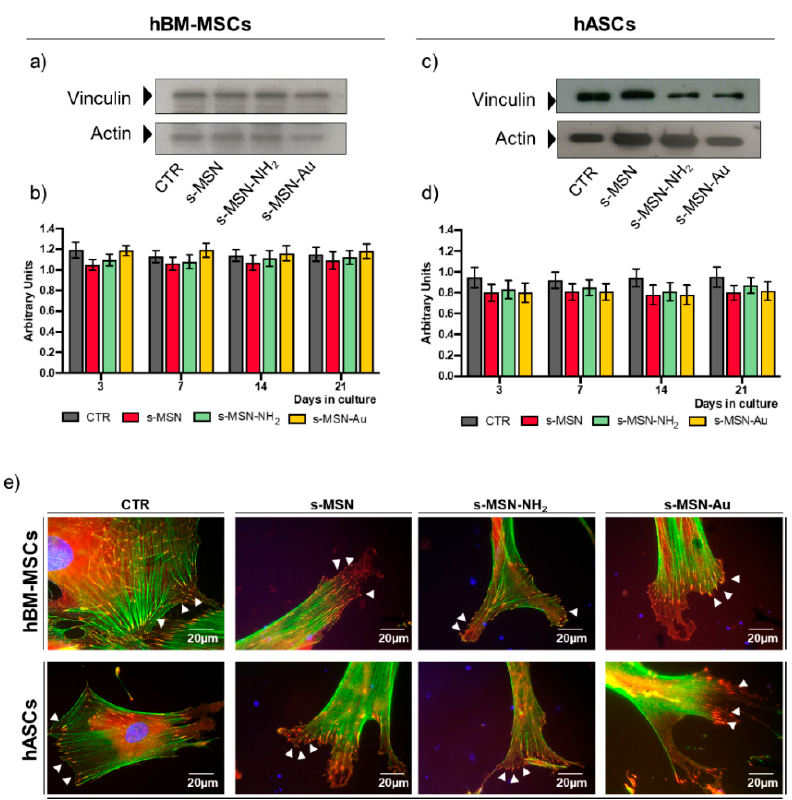
Figure 9. Vinculin expression of both human adult mesenchymal stem cells on s-MSN, s-MSN- NH 2 , and s-MSN-Au. ( a , c ) Representative Western blotting bands of Vinculin expression and ( b , d ) related quantification by the densitometric analysis at each time point of culture. The results of each bar are the mean ± SEM of three independent experiments. p < 0.05 was considered significant. ( e ) Representative images of F-Actin (Phalloidin-Alexa-fluor-488, GREEN) and Vinculin (anti-Vinculin, RED), and Nuclei (DAPI, BLUE). Scale bar = 20 µm.